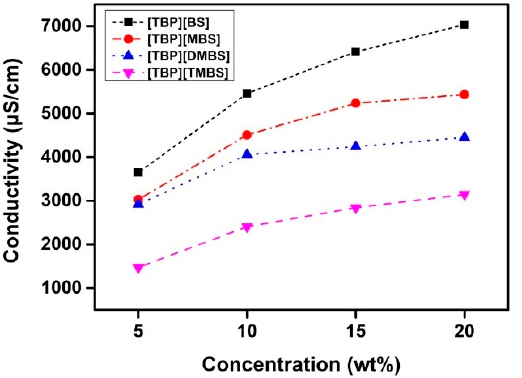
Figure 5. Conductivity of [TBP][BS], [TBP][MBS], [TBP][DMBS], and [TBP][TMBS] aqueous solutions according to solution concentration.